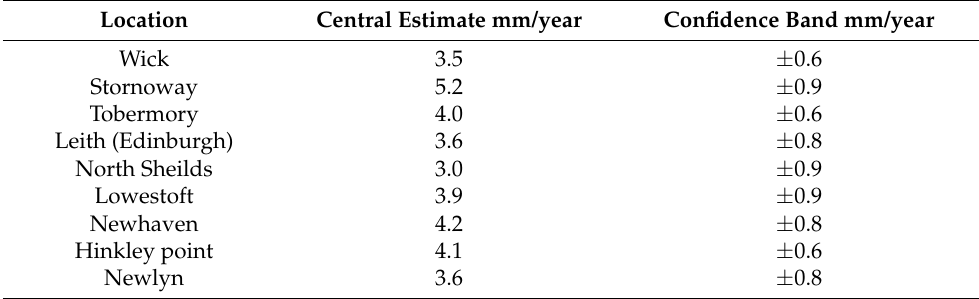
Table 1. Trends in sea level (linear, 1991 – 2020), adjusted for land movement, after [4].